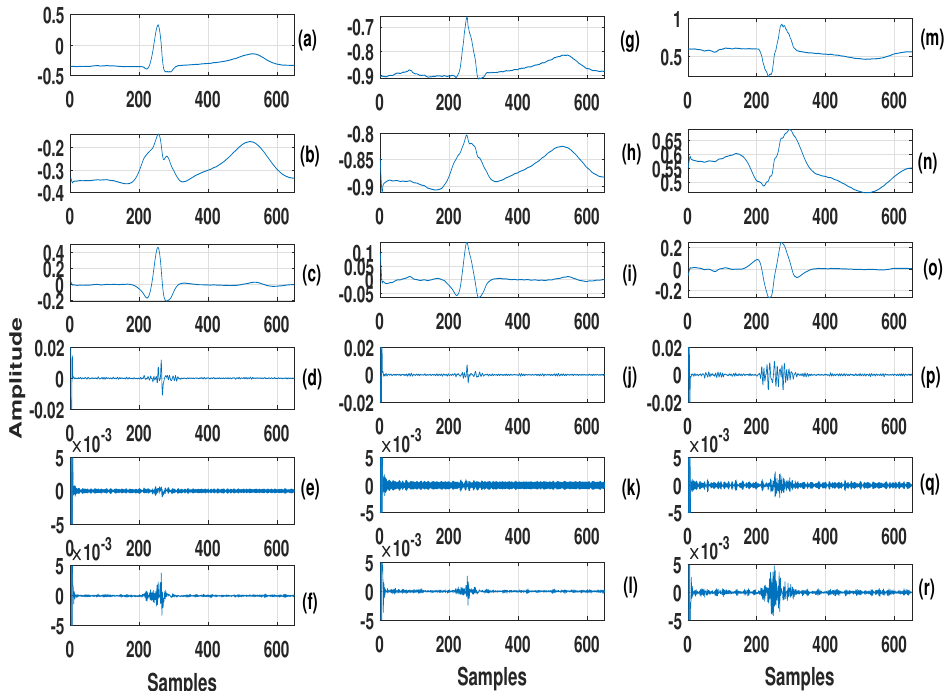
Figure 2. ( a ) V x lead VCG signal for NSR class. ( b – f ) mode 1 to 5 of V x lead VCG signal for NSR class. ( g ) V y lead VCG signal for NSR class. ( h – l ) mode 1 to 5 of V y lead VCG signal for NSR class. ( m ) V z lead VCG signal for NSR class. ( n – r ) mode 1 to 5 of V z lead VCG signal for NSR class.